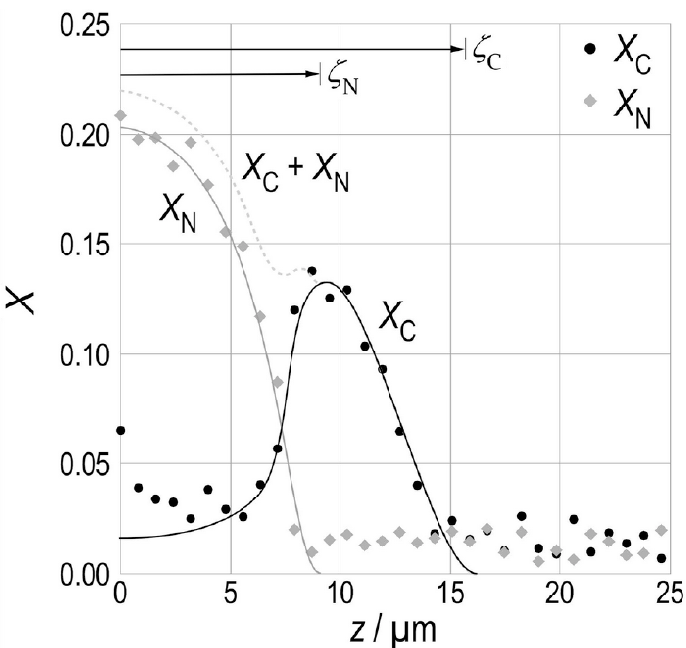
Figure 5. Fraction–depth profiles of nitrogen and carbon in an AISI-316L ferrule, obtained by SAM. The solid curves are Bézier curves intended to estimate the true fractions of carbon and nitrogen in solid solution, accounting for nitride formation and artifacts of SAM. The dashed curve displays their sum, i.e., the total fraction of interstitial solute as a function of